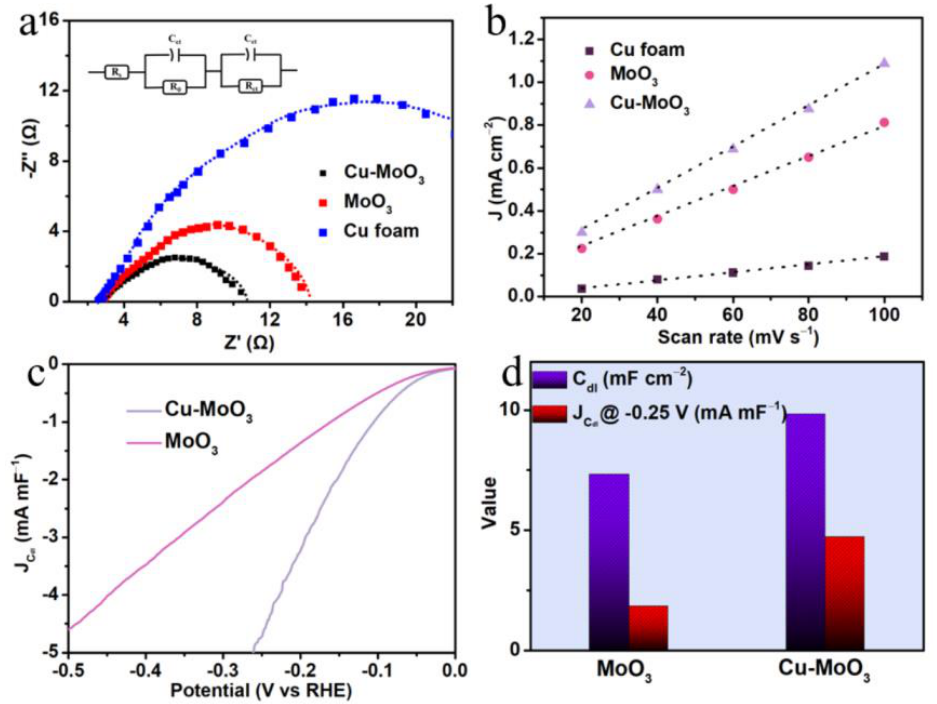
Figure 6. ( a ) The EIS spectra, inset: image of equivalent circuit model, ( b ) double-layer capacitance plots of Cu foam, MoO 3 and Cu-MoO 3 , ( c ) C dl normalized performance and ( d ) the performance comparison of MoO 3 and Cu-MoO 3 samples.